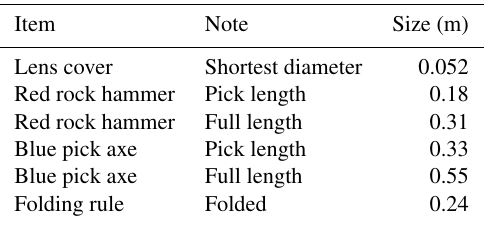
Table 11. Sizes of various items included for scale in images from the data set given by Lasser et al. (2020a).